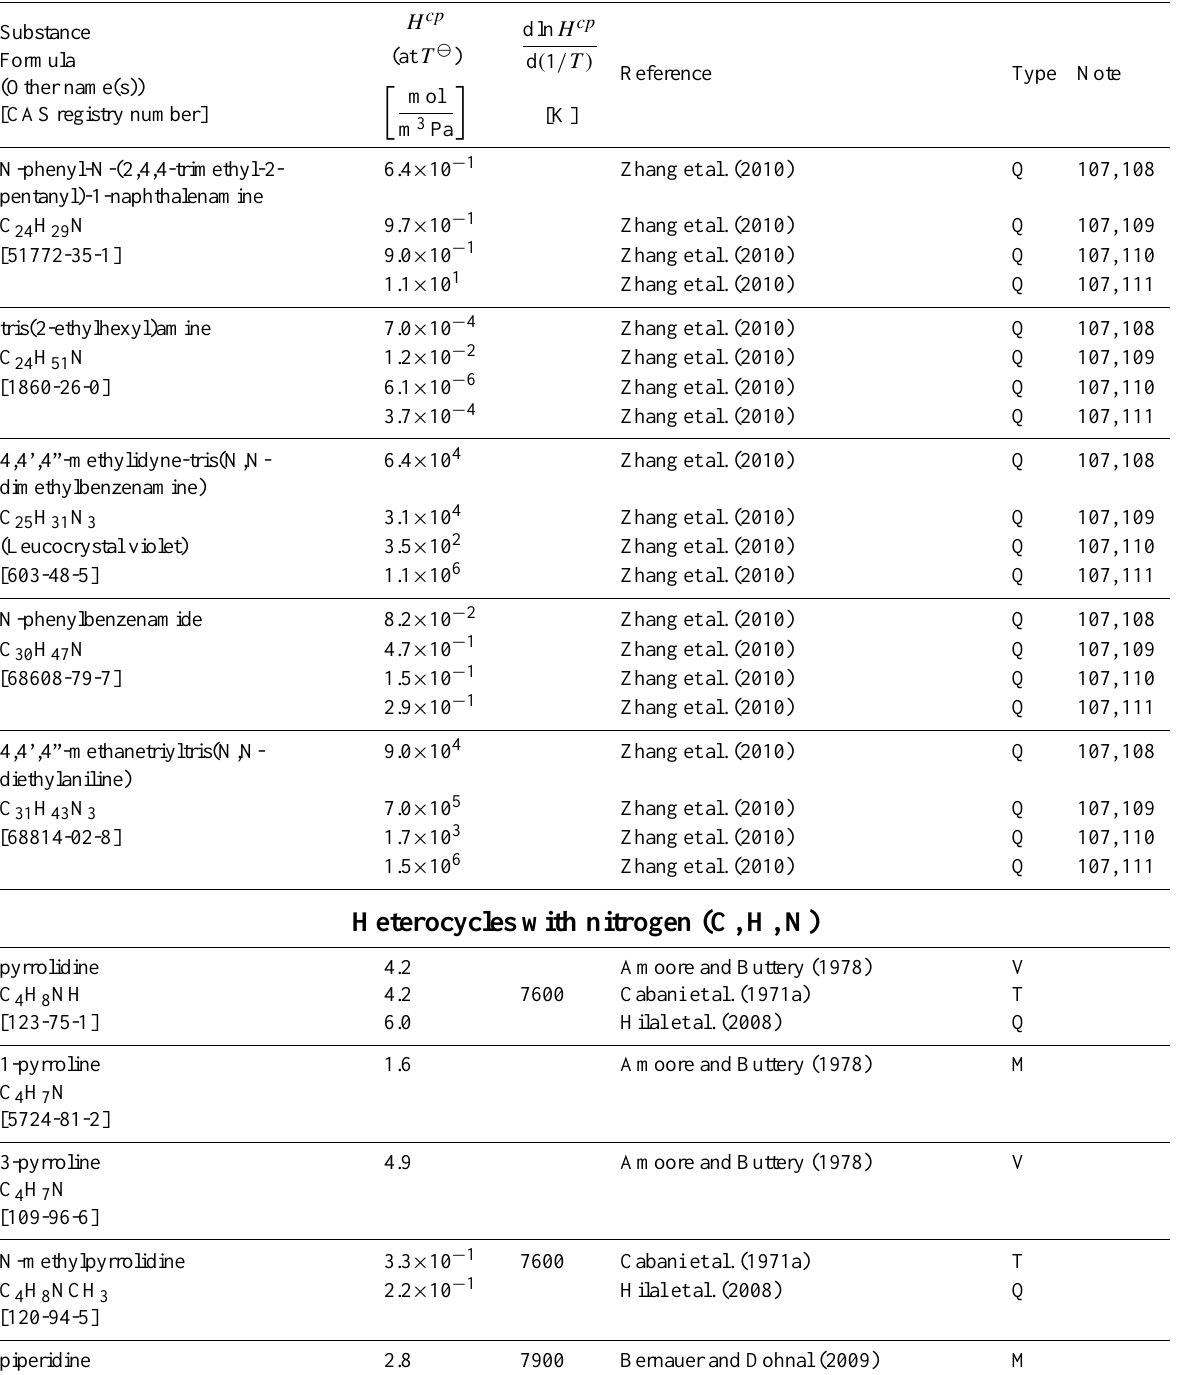
Table 6: Henry’s law constants for water as solvent